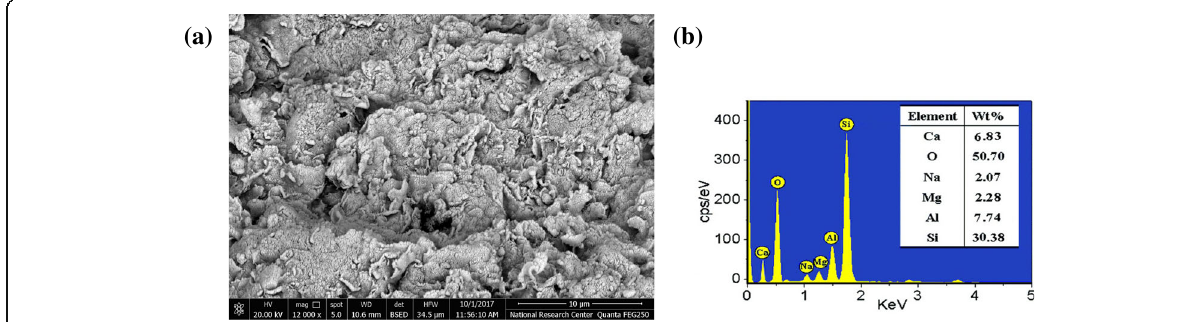
Fig. 4 SEM and EDAX of the raw clay. a Scanning electron micrograph showing a well-crystallized montmorillonite with well-developed “ oak leaf ” and cellular morphology with tightly interwoven flakes. b EDAX analysis of Ca-montmorillonite